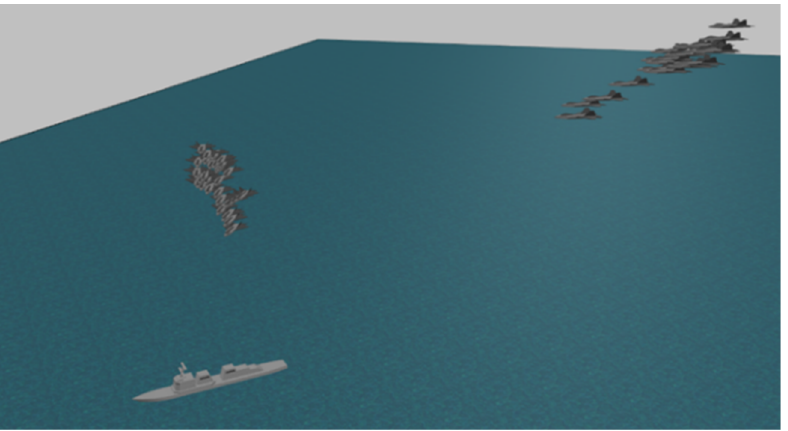
Figure 18. The simulation in Any-logic platform.